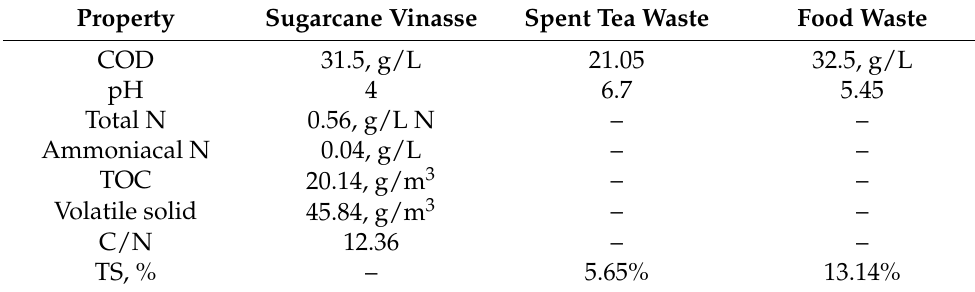
Table 1. Feedstock’s